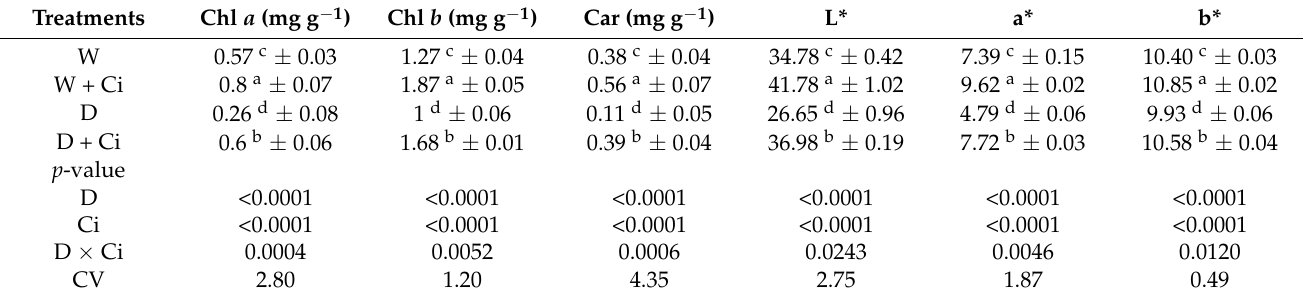
Table 2. Chlorophyll (Chl a , Chl b ), carotenoid (Car), L* (Brightness/Lightness), a* (Red- ness/Greenness), and b* (Yellowness/Blueness) content of Calendula officinalis treated with